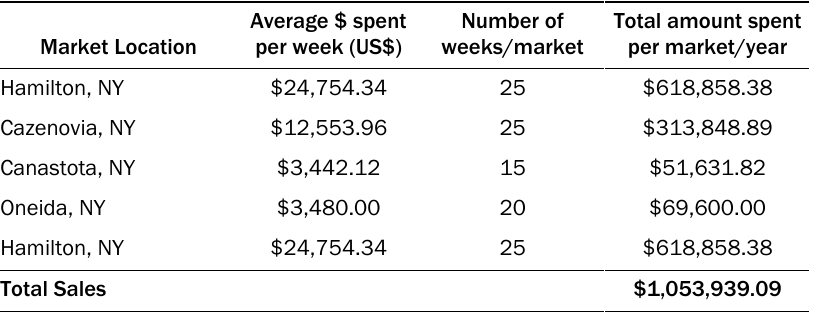
Source: Madison County Agricultural Economic Development Program records